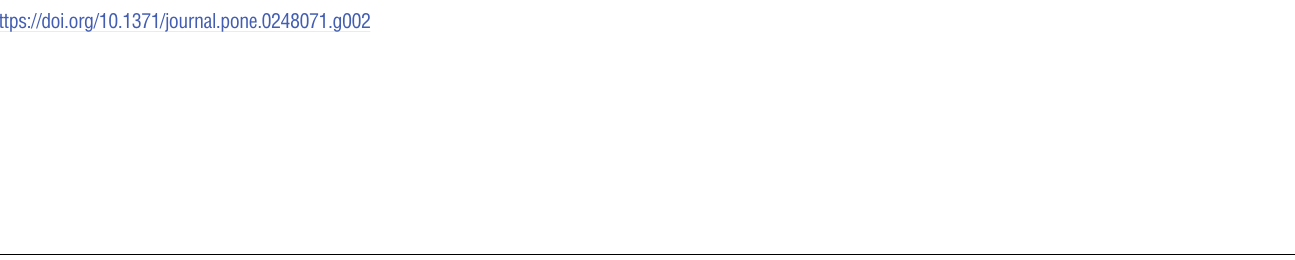
Fig 2. Covariate response curves for the three modelled periods: From top to bottom the plots correspond to the covariates included in the (a) 1999 winter model (red), (b) the 2003 winter model (black), and (c) the all data model (blue). Grey shading indicates ± 2 standard error bounds for models covariates. Plot produced in R package ‘visReg’